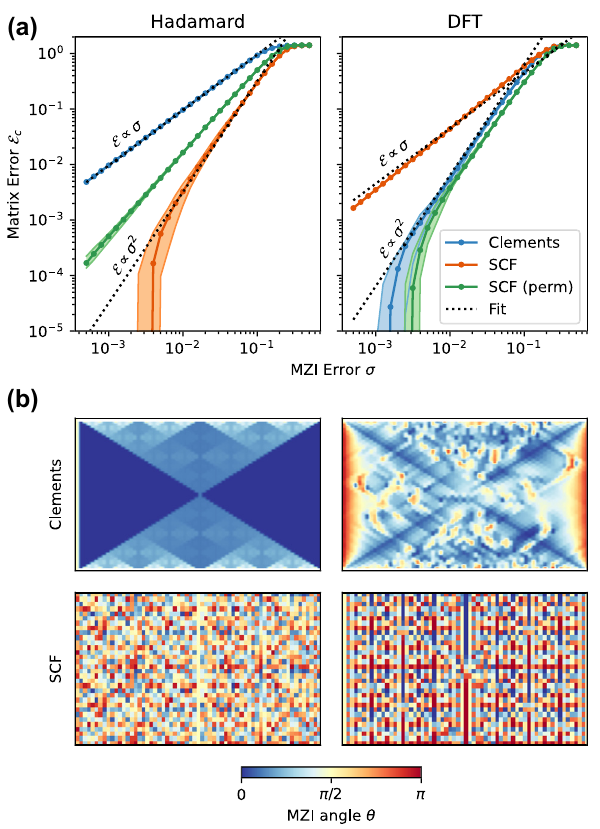
Figure 4: Realization of Hadamard and DFT matrices with Clements and SCF meshes. (a) Post-correction error  splitter angles 𝜃 for meshes of size N = 64 realizing Hadamard and DFT